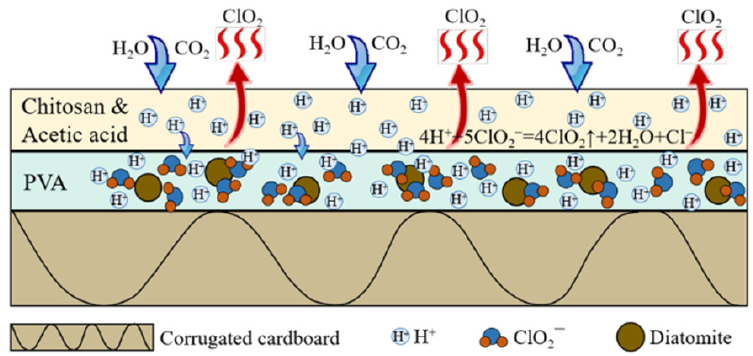
Figure 2. Schematic diagram of the release process of ClO 2 from the coated corrugated cardboard.